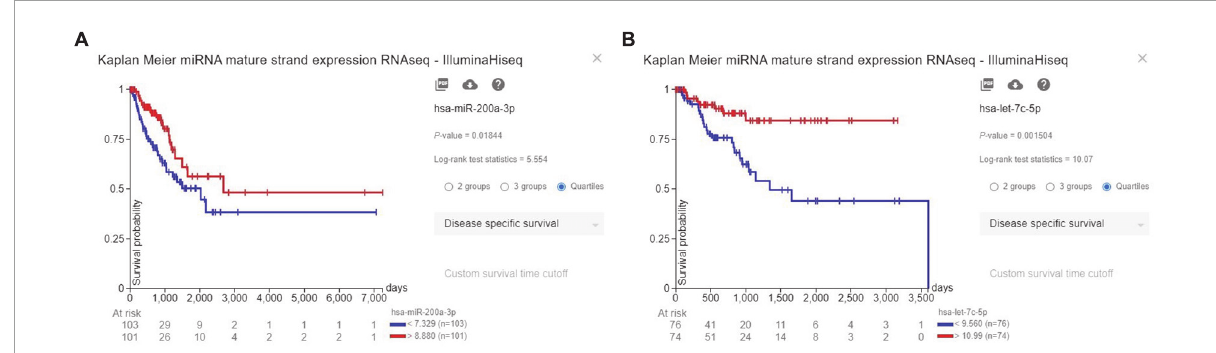
FIGURE5 Identifying programmed death-ligand 1 (PD-L1) expression pattern in the included non-small cell lung cancers (NSCLCs) microenvironment. (A) The clustering and cell annotation displayed nine cell clusters in the included tumor microenvironment of NSCLCs. (B) PD-1 is considerably expressed in the T-cells, CD8 + T-cells, CD4 Treg, DCs, and ILC2 in the included NSCLCs